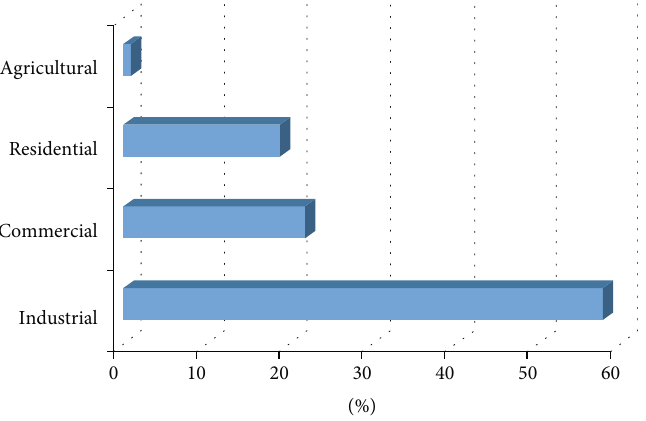
Figure 5: Sectoral shares of electricity consumption based greenhouse gas